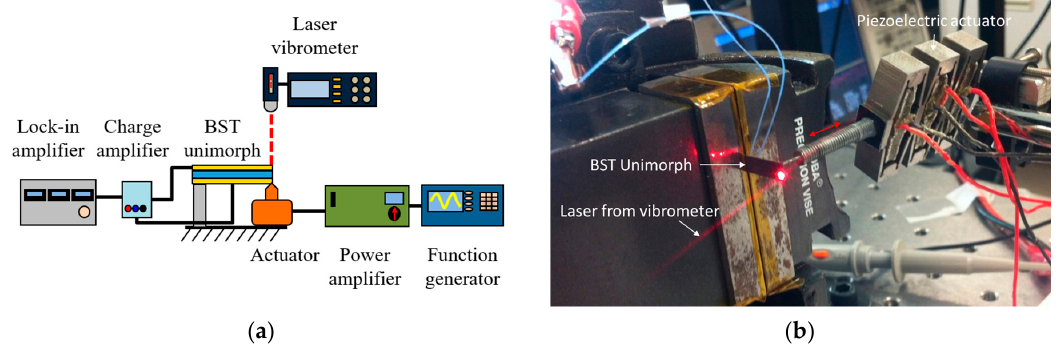
Figure 2. The experimental setups of the unimorph sensing element: ( a ) Whole experimental setup and ( b ) Actual test setup.